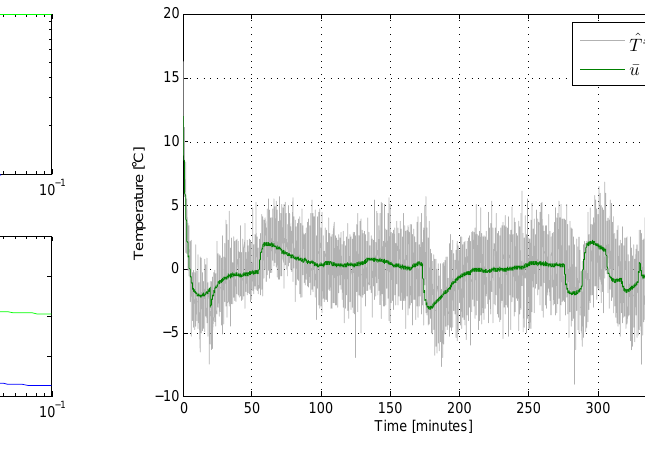
Figure 8: The silicon pyrometer, ˆ T s , and the rescaled graphite pyrometer, ¯ u , after being detrended and highpass-filtered through 1